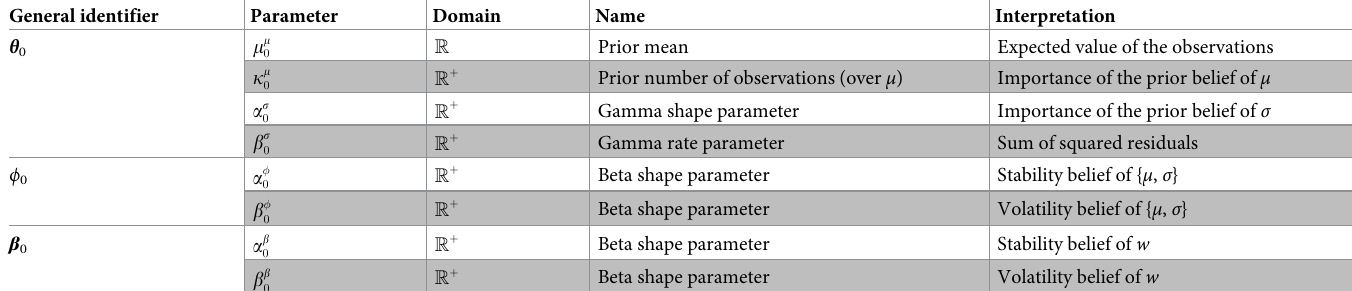
Table 1. HAFVF prior parameters in the case of normally distributed variables. Horizontal lines separate the various